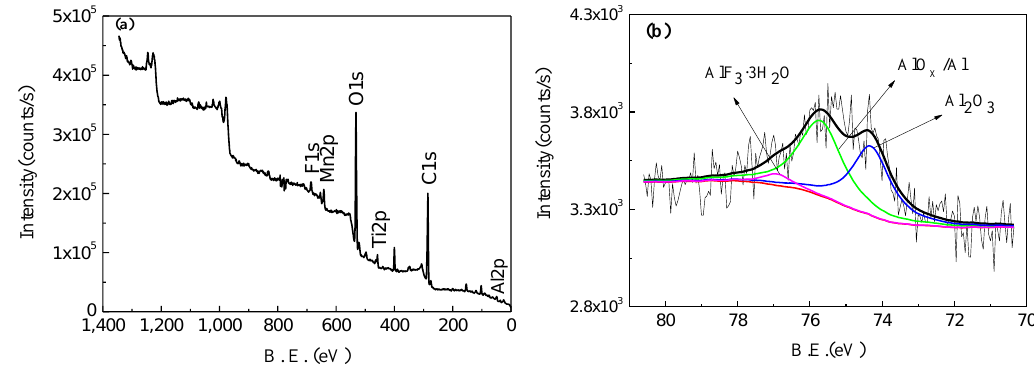
Figure 4. Cont. Figure 4. Cont.